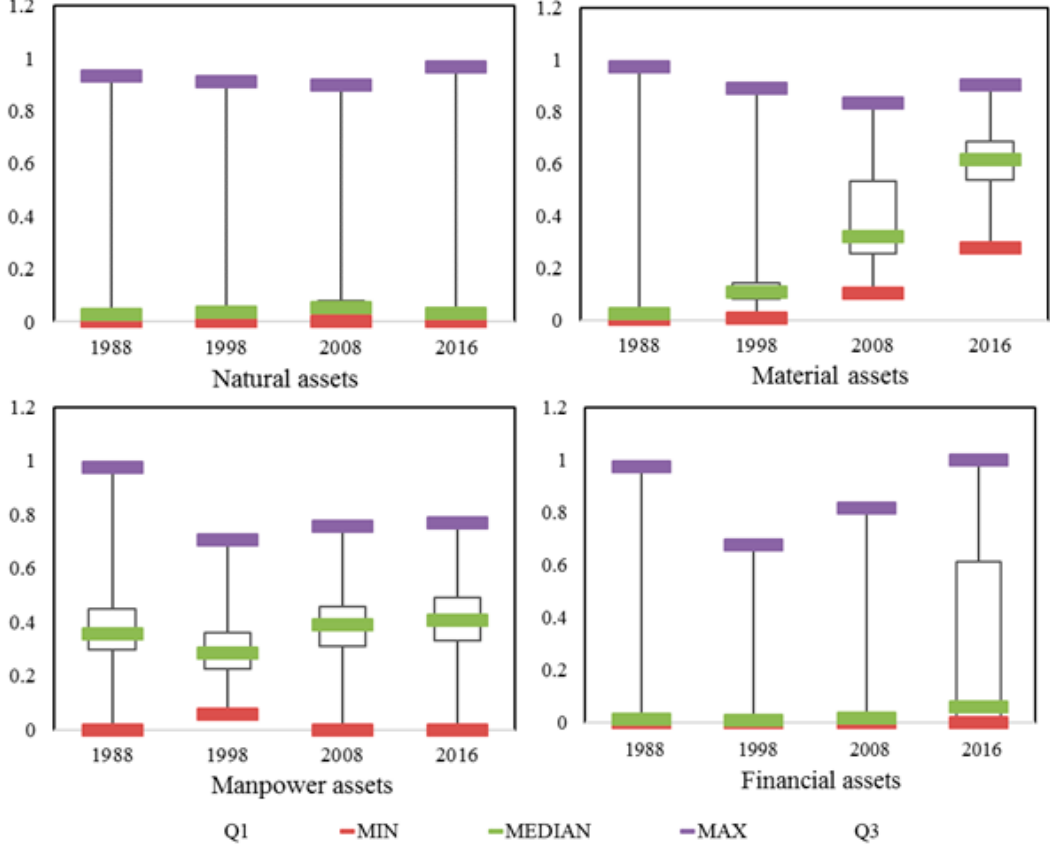
Figure 2. Map of the livelihood asset values of households in Sihe village.